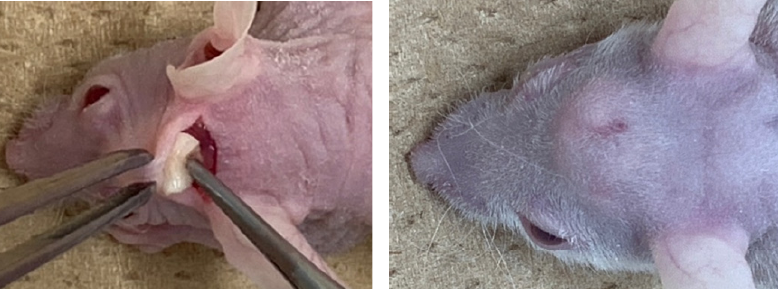
Figure 8. Gross views at CGF graft surgery (left) and dome-like uplift at 14 days